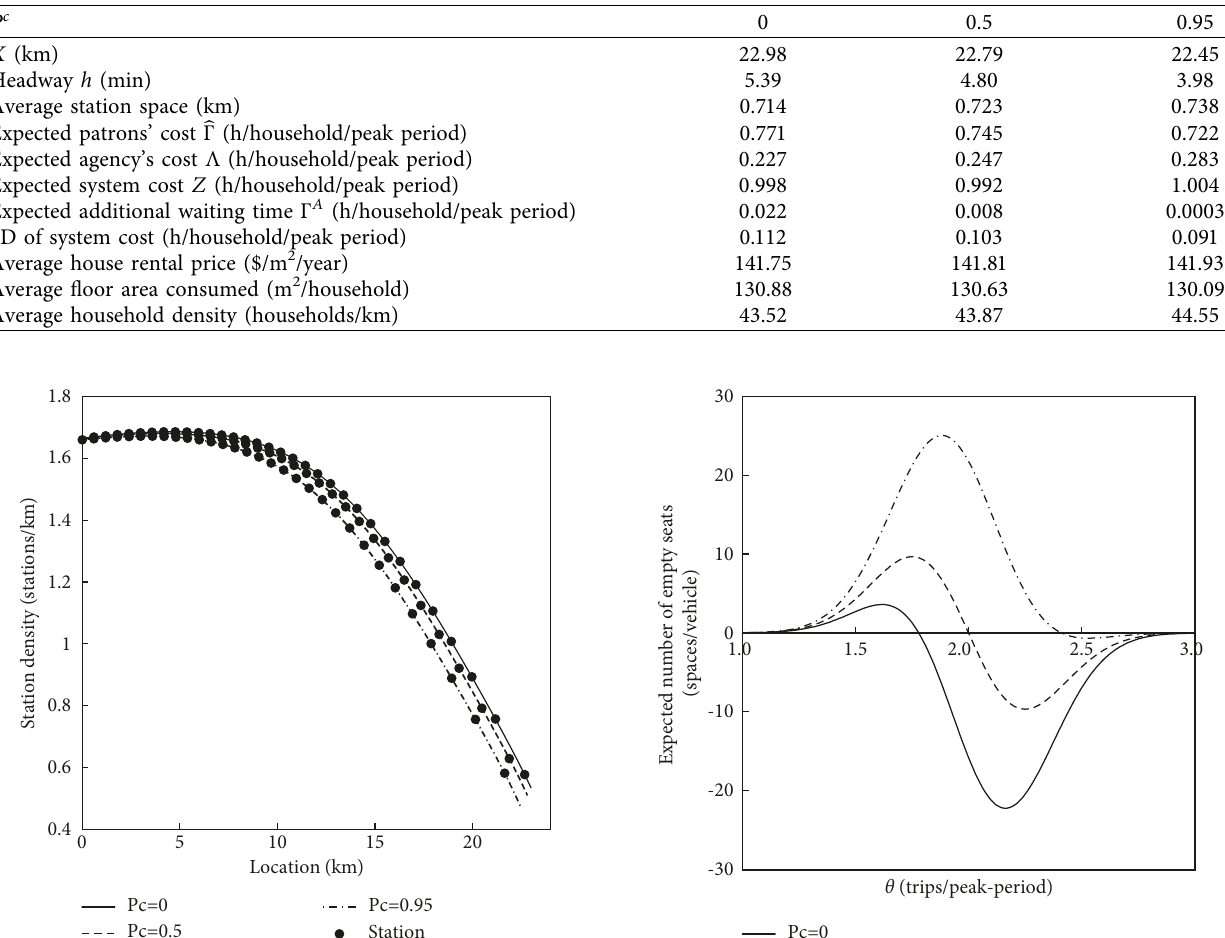
Table 3: Result of the proposed model under different desired levels of service reliability.